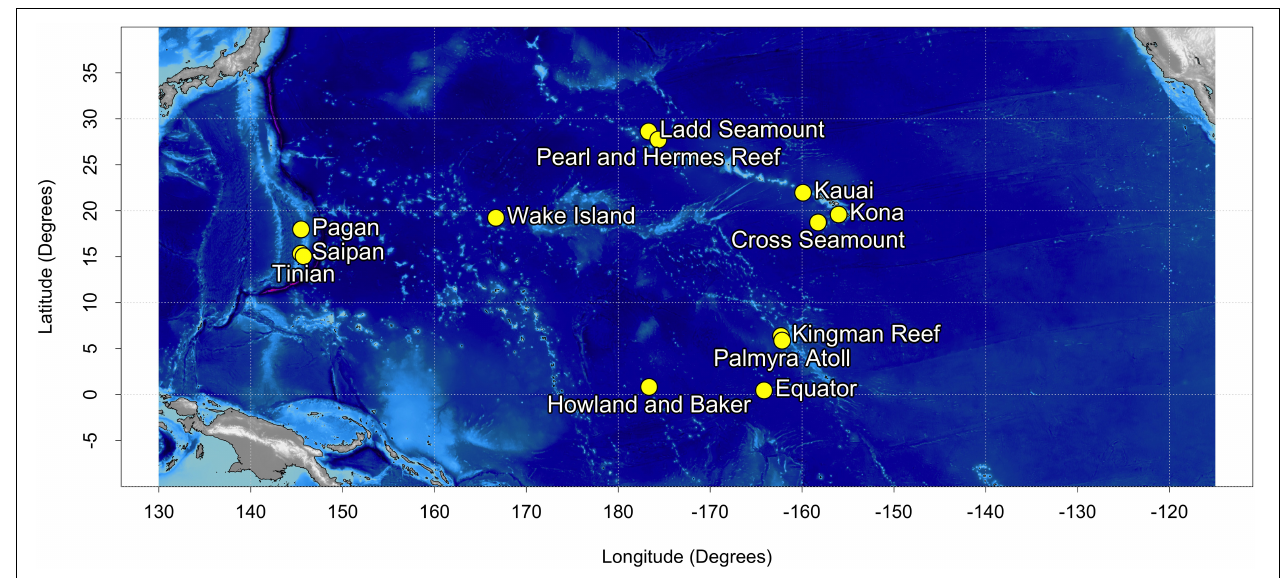
FIGURE 1 | Map of the 13 acoustic recording